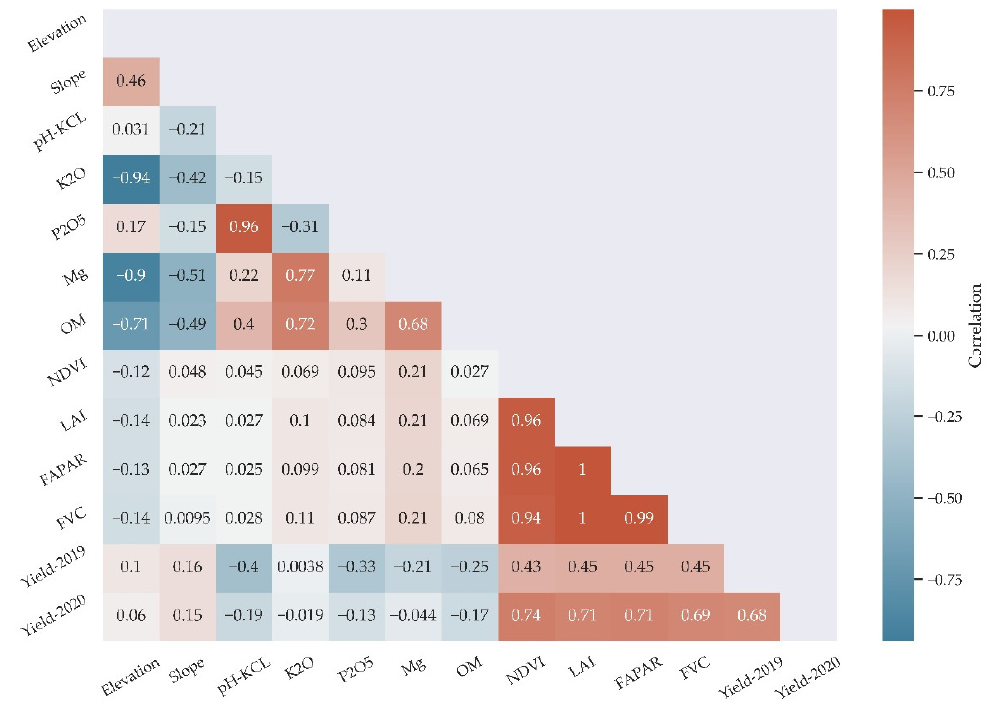
Figure 8. Spearman’s correlation matrix amongst soil attributes, RS data, yield data and geomorphol- ogy data.